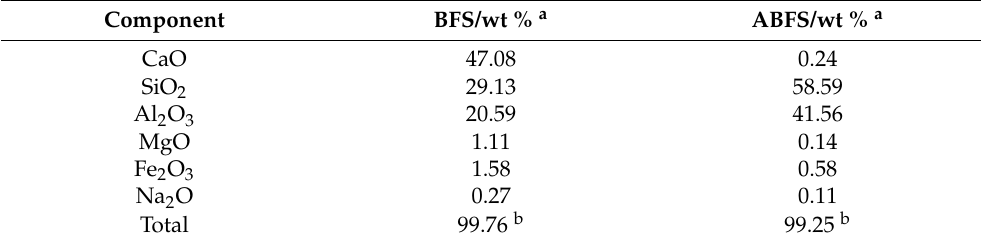
Table 1. Determination of chemical composition of blast furnace slag (BFS) and activated BFS (ABFS). Component BFS/wt %